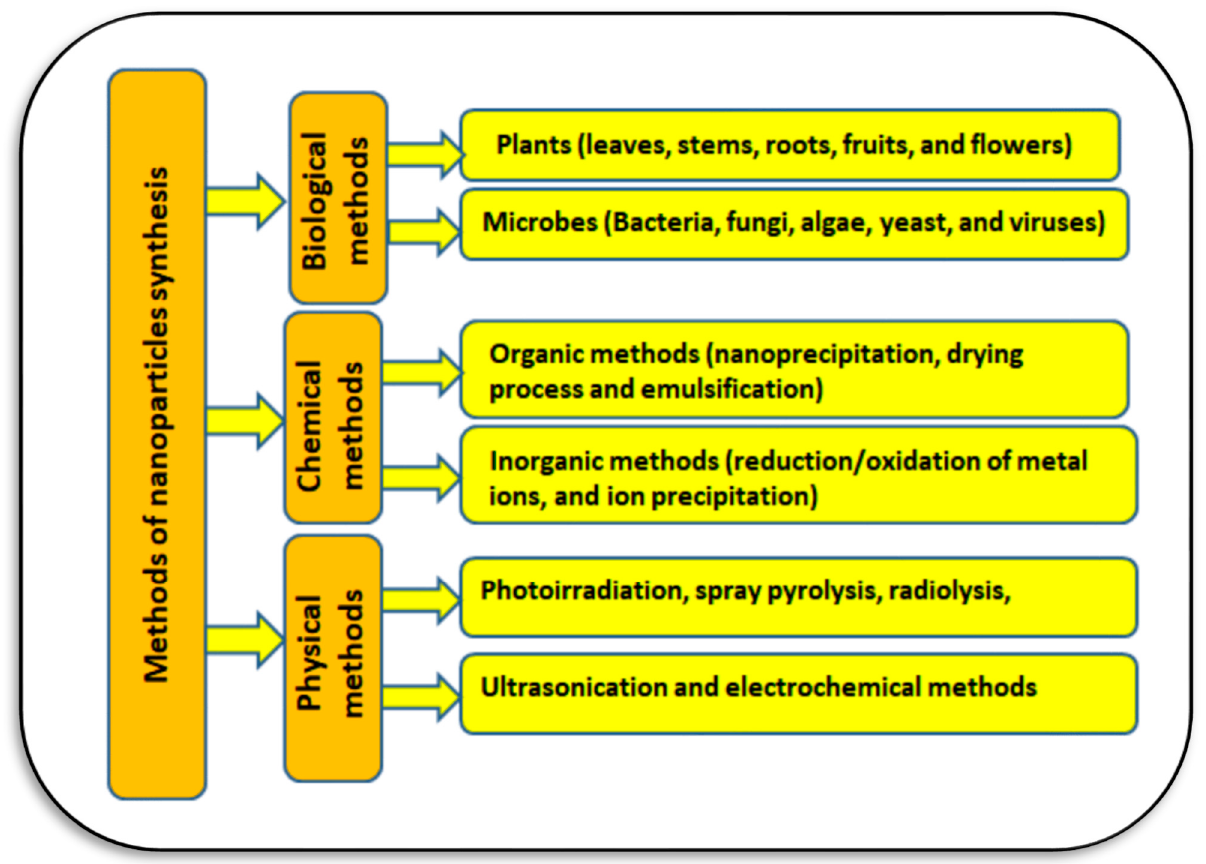
Figure 12. The common methods used in nanoparticle synthesis and their classification into physical, chemical, and biological methods (Sources: [62,95,112]).